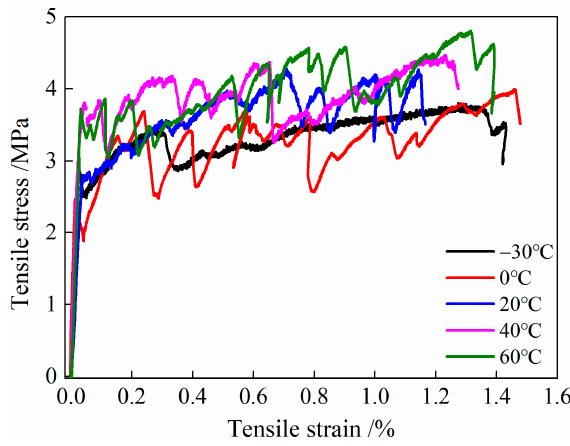
Table 6. Feature parameters of tensile property for HDC.